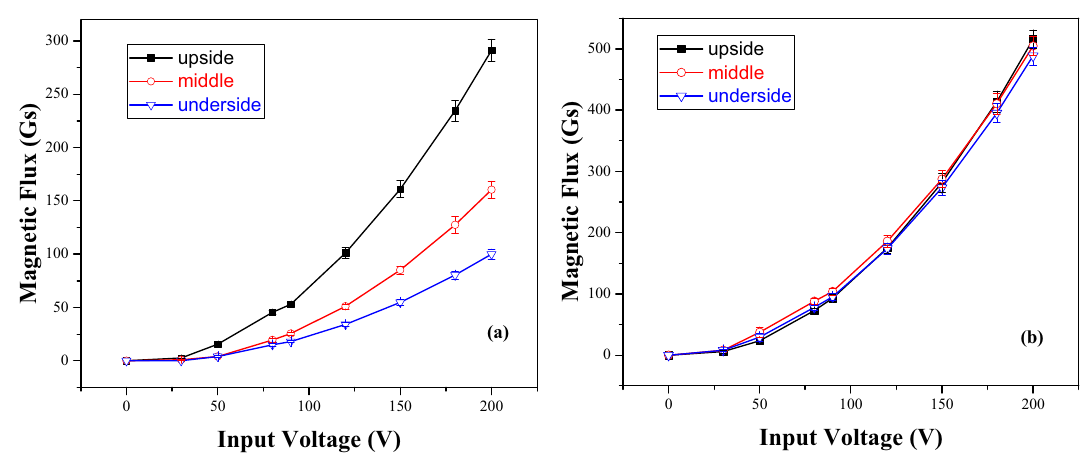
Figure 10. Measured magnetic flux of electromagnetic stirrer at idle load 29 ( a ) centre location, ( b ) right grains. The samples were etched by the Keller’s reagent, or deep corroded using 10% NaOH aqueous solution cooked at 80 °C for 10 min. The microstructure was observed by OLYMPUS BX60M optical microscope and HITACHI S3400n scanning electron microscope, which equipped with an energy dispersive X-ray spectrometer (EDX) to confirm the chemical composition of the phases. The phases were identified by using a Bruker D8 Discover X-ray diffractometer (XRD) using Cu Kα 1 radiation.